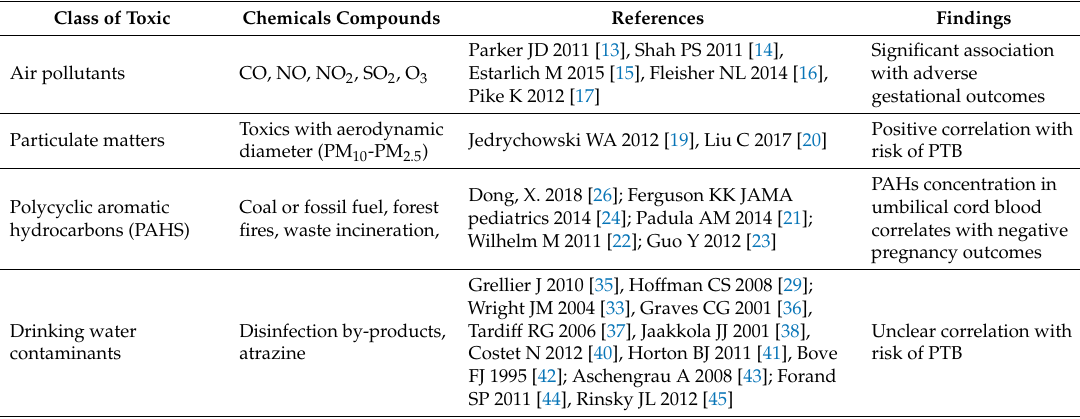
Table 2. Studies on environmental chemical exposure and preterm birth. PCB, polychlorinated biphenyls; PPROM, Preterm Premature Rupture of